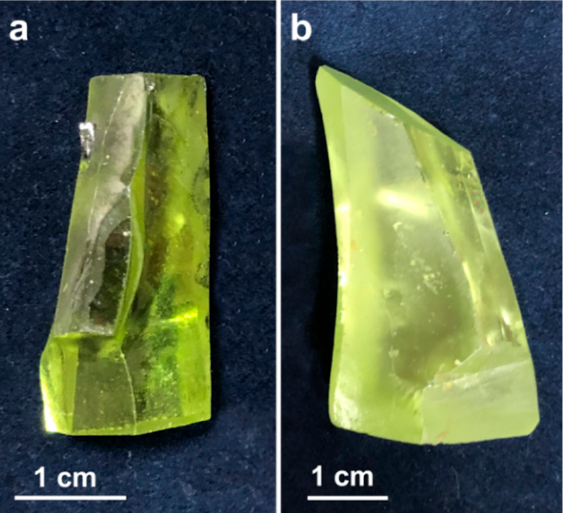
Figure 1. Photographs of as-grown crystals: ( a ) (ZrO 2 ) 0.805 (Y 2 O 3 ) 0.188 (Pr 2 O 3 ) 0.007 ; ( b ) (ZrO 2 ) 0.802 (Y 2 O 3 ) 0.195 (Pr 2 O 3 ) 0.003 .